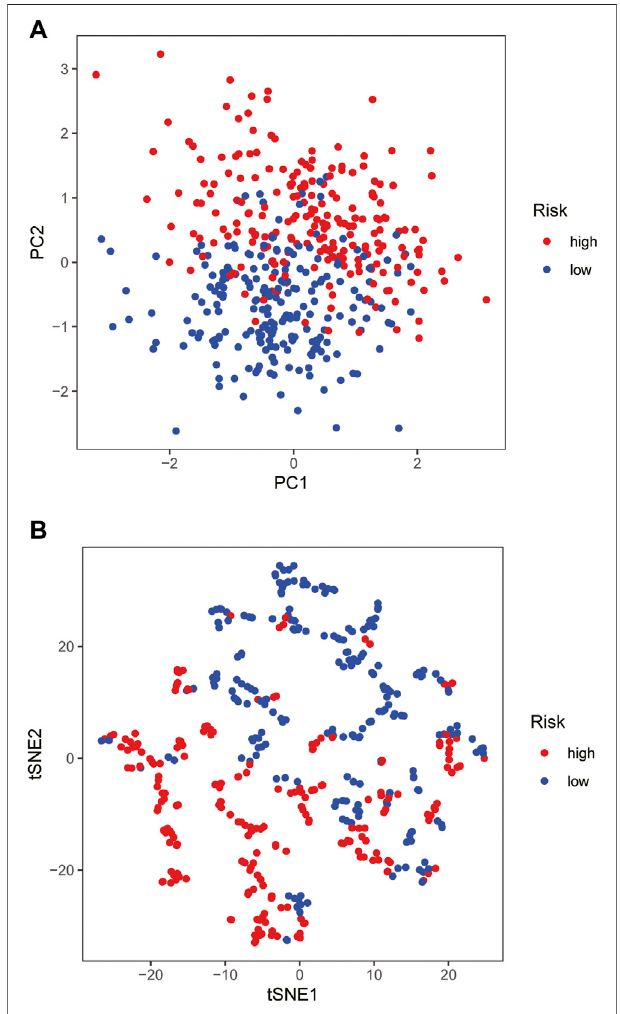
FIGURE 2 | Construction of risk-scoring model (A,B) PCA and t-SNE based on the expression pro fi le of the 3 selected signature genes separated different risk